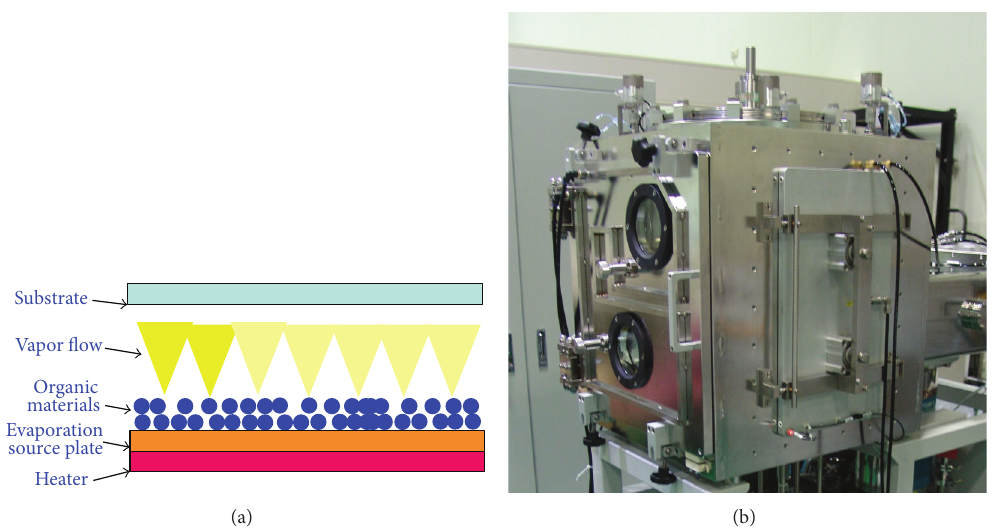
Figure 1: Illustration of (a) the concept and (b) photograph of the novel evaporation system.